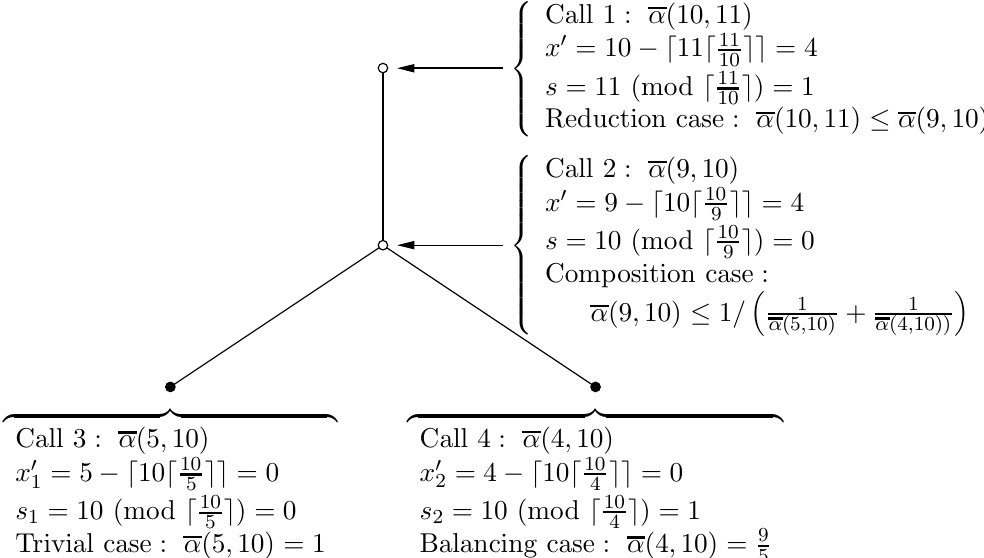
The progress tree of Algorithm α ( x, k ) for Example 2 where we seek a normalised 11 –partite D ∆ –colouring. 10